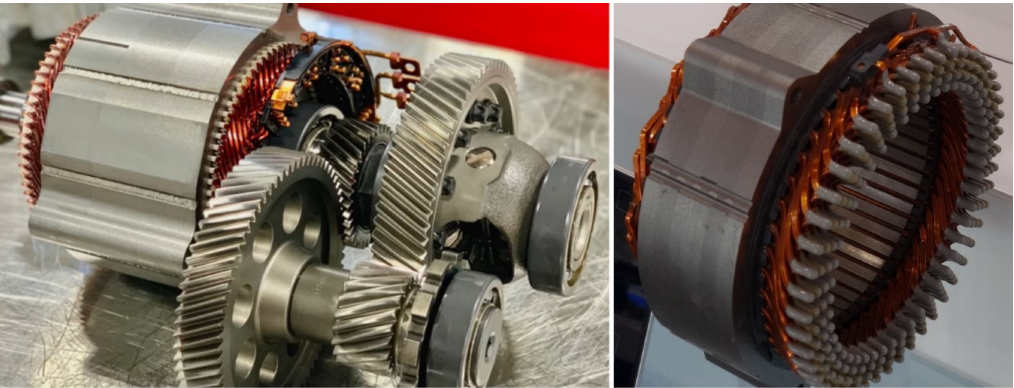
Figure 8. Hairpin windings used in electric vehicle motors ( Left ) Chevrolet Bolt [35]; ( Right ) Toyota Prius 4th generation [36].